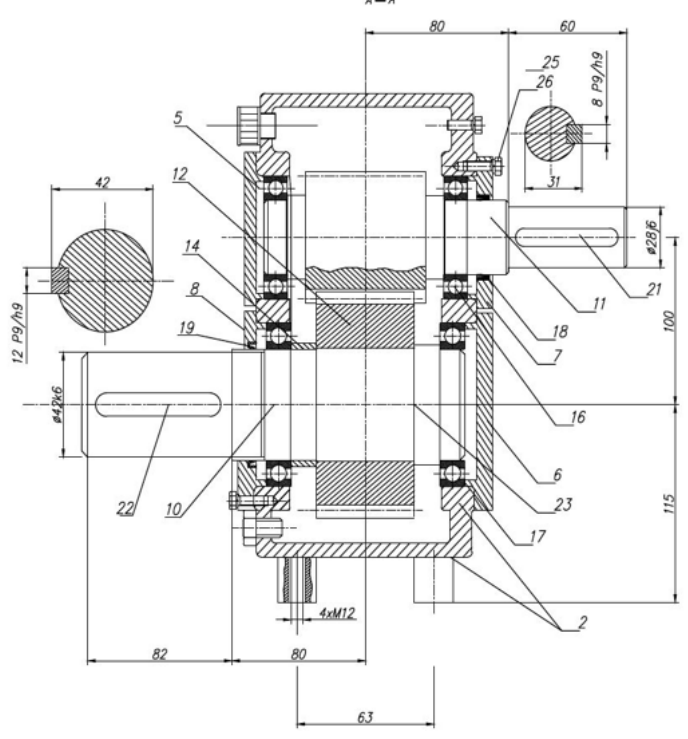
Figure 21. Construction form of the gearbox after the changes were made.